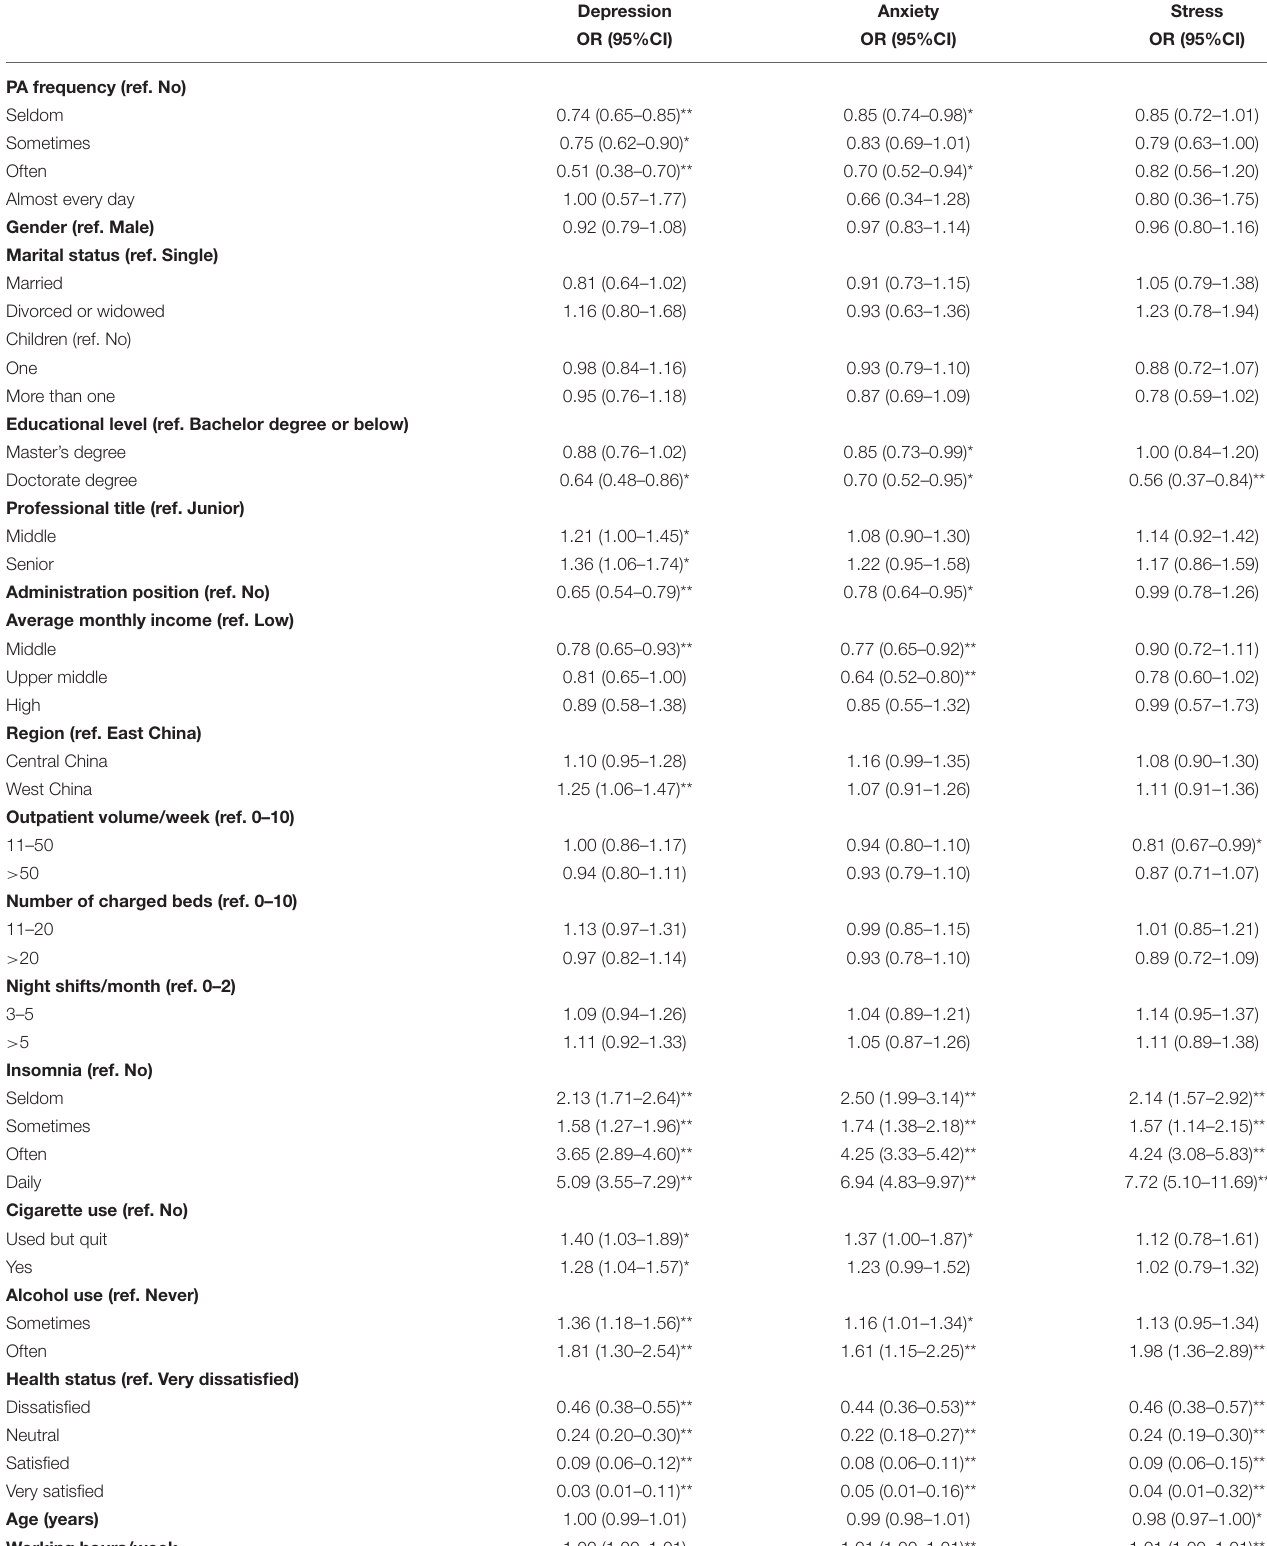
TABLE 2 | Ordinal logistic regression examining factors associated with depression, anxiety, and stress ( N = 4,520). Depression Anxiety